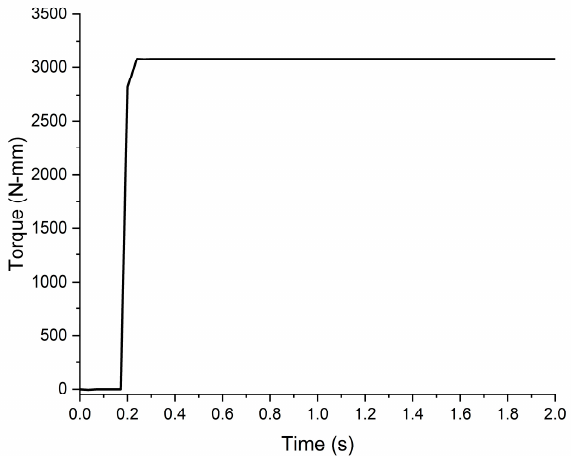
Figure 14. Torsion analysis result.